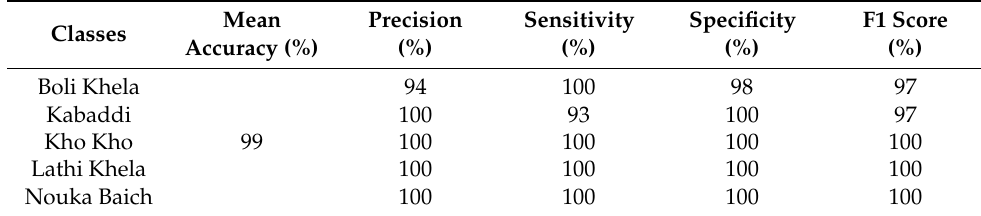
Table 6. Class-wise performance of Model 9.